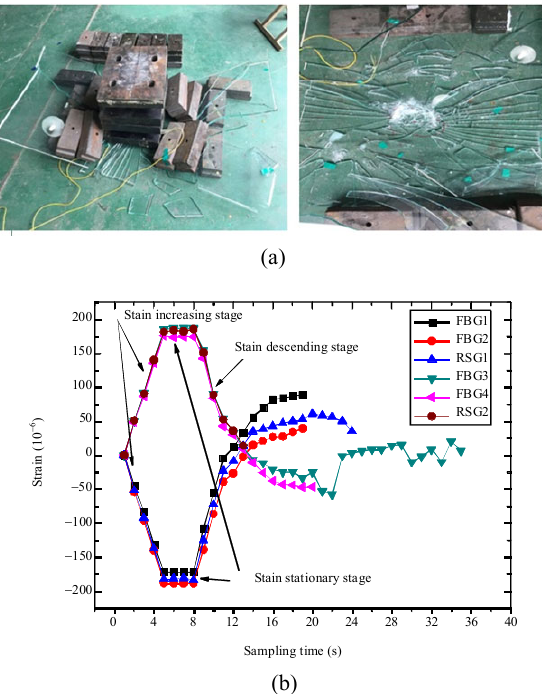
Fig. 11 Results of the damage test: (a) broken photo of the glass panel and (b) strain curve in the broken